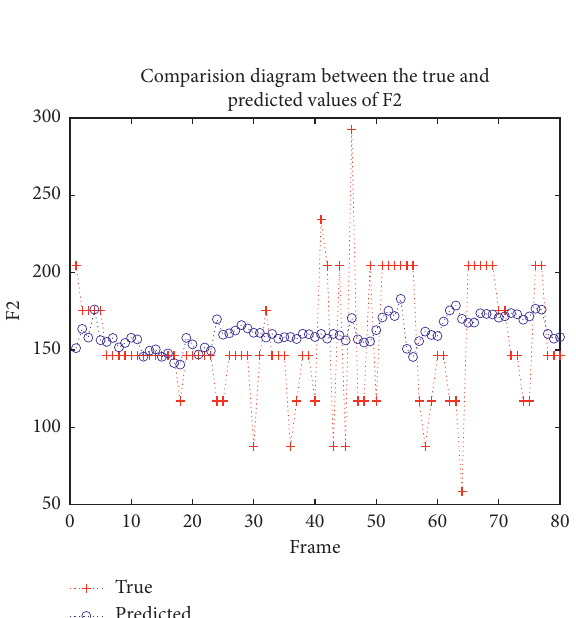
Figure 5: Conversion results using